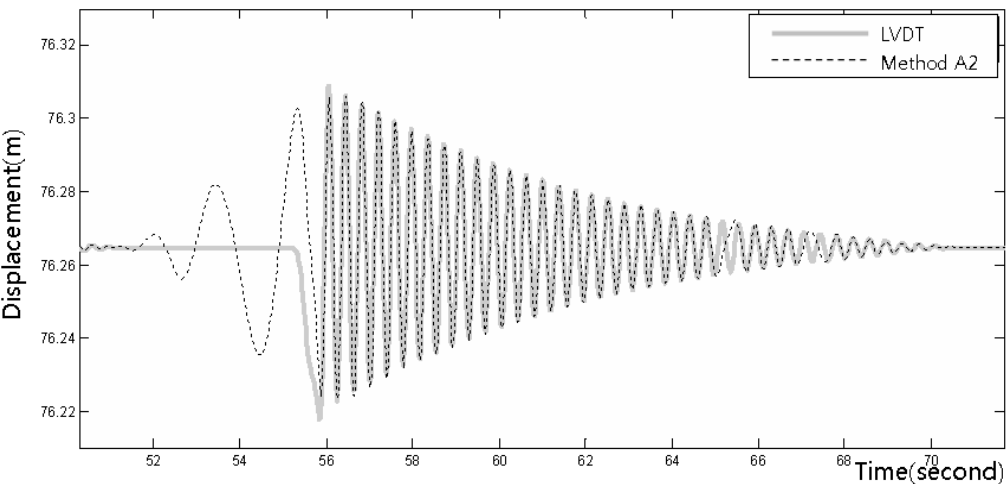
Figure 9. Displacement measurements from the LVDT and the accelerometer (Method A2).